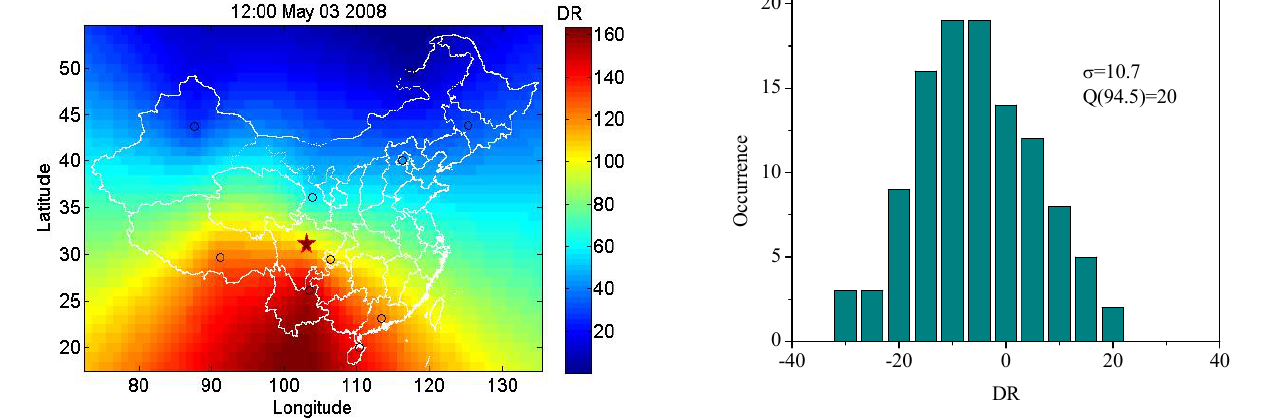
Fig. 5. The standard deviations ( σ ) and the distribution of DR during the interval of 10–19 May 2008 over Chongqing station.